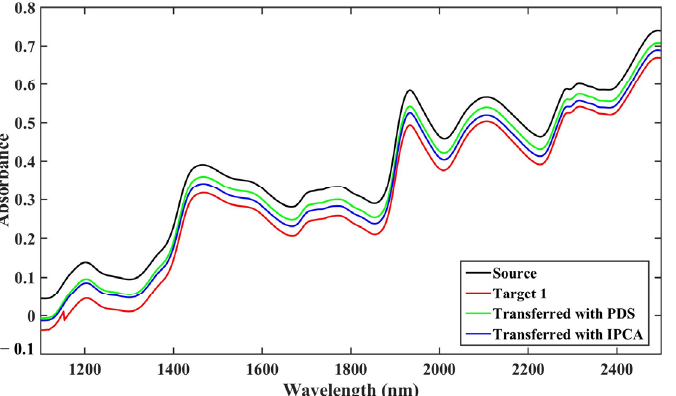
Figure 5. Raw and transferred spectra of arbitrarily selected sample in dataset 2 from source to target 1. Table 2. Calibration transfer results obtained by PDS and IPCA for dataset